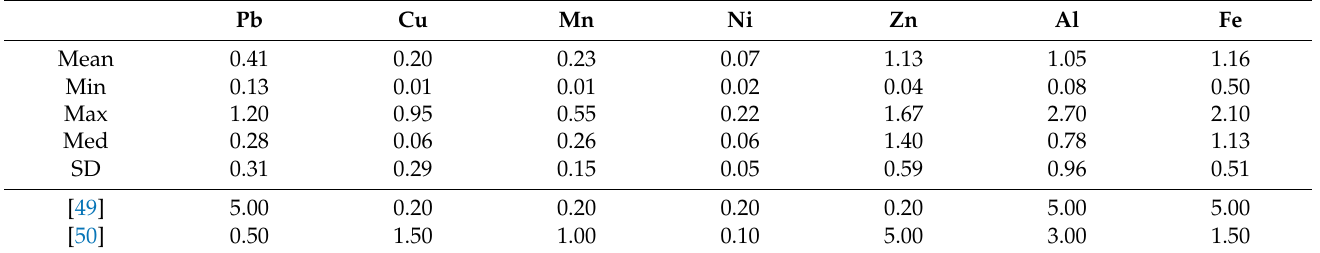
Table 1. Summary statistics of heavy metal concentrations (mg/L) in water of Bahr El-Baqar drain. Pb Cu Mn Ni